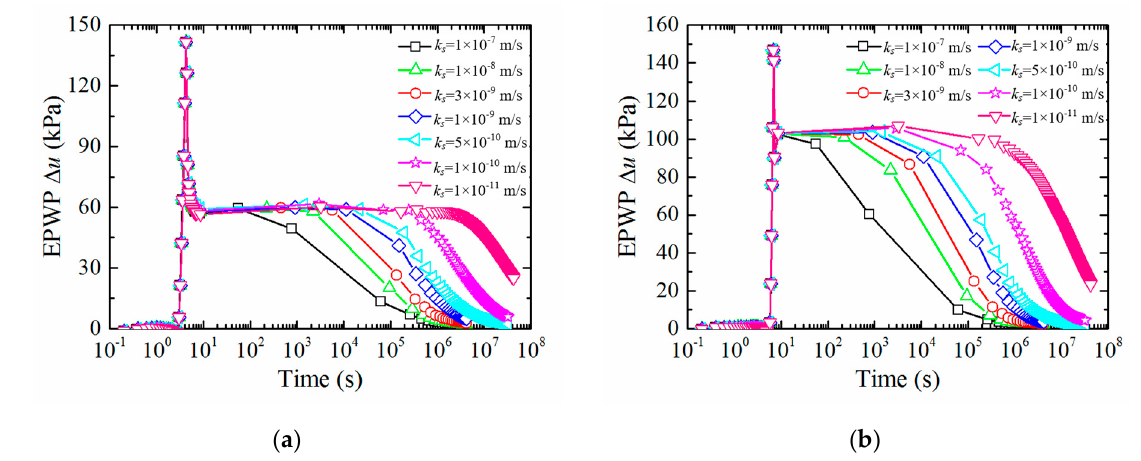
Figure 10. Development and dissipation of EPWPs during and after pile installation under various soil permeability coefficients. ( a ) At depth of 4.9 m; ( b ) at depth of 7.5 m.